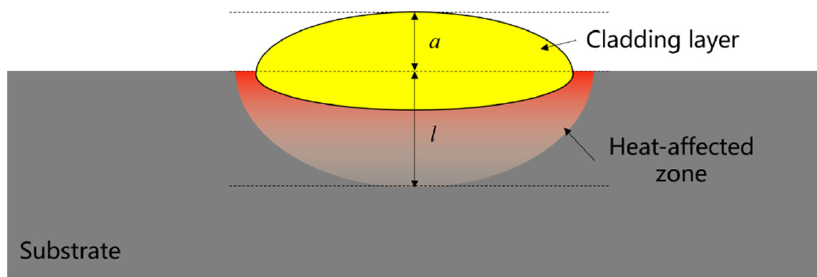
Figure 1. Schematic showing the cladding layer and the heat ‐ affected zone.